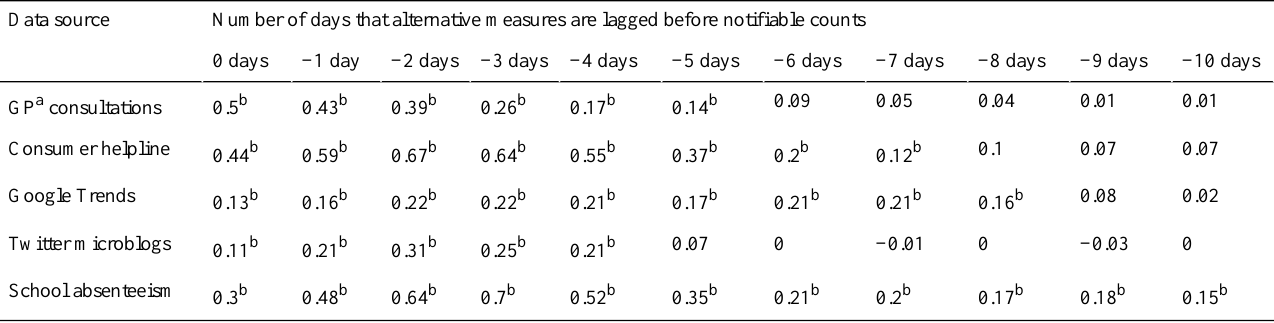
Table 2. Correlation and lagged transformed correlation of alternative predictors with notified case counts of campylobacteriosis. Number of days that alternative measures are lagged before notifiable countsData